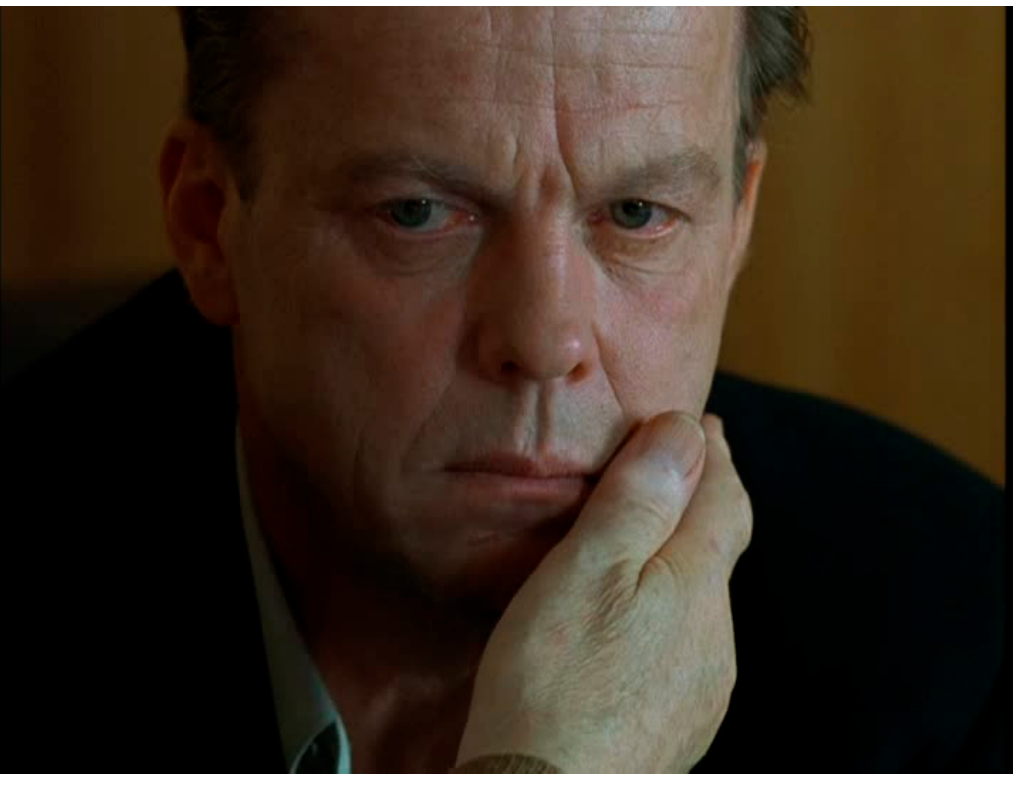
Figure 13. Reflexive Touch: Bergman/David.